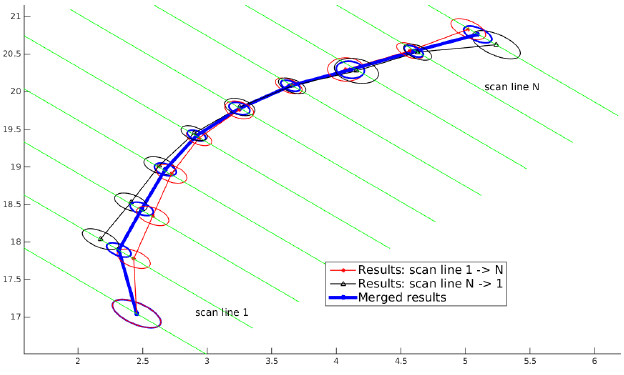
Figure 4. The utility segment after merging the corresponding utility segments from two directions. Uncertainties of utility states are shown by ellipse with 95% confidence